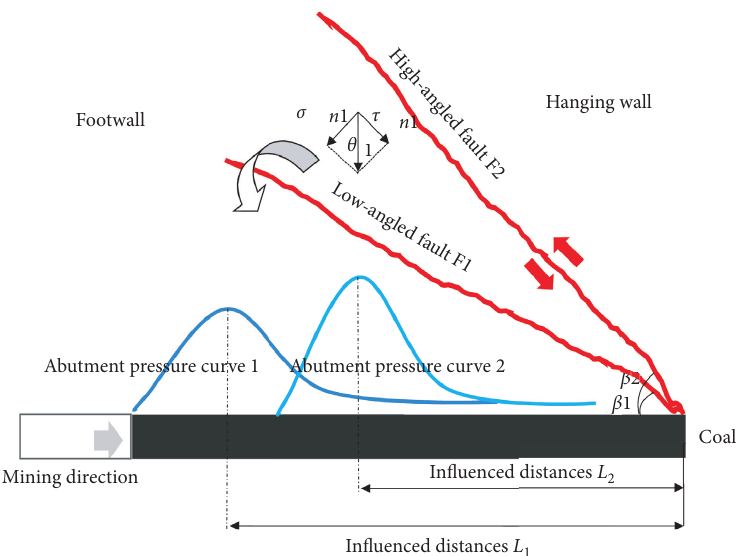
Figure 6: Effect of fault dip on surrounding rock